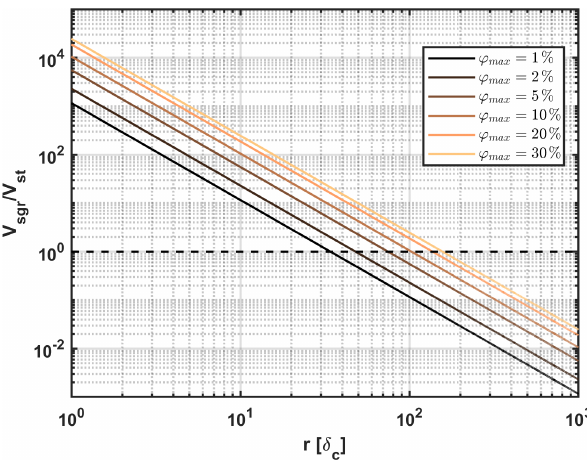
Figure 1. The segregation to Stokes velocity ratio, following Eq. (22), is given as a function of initial perturbation radius r in terms of compaction length δ c . Each colored line refers to differ- ent values of perturbation amplitude ϕ max , which are given in the